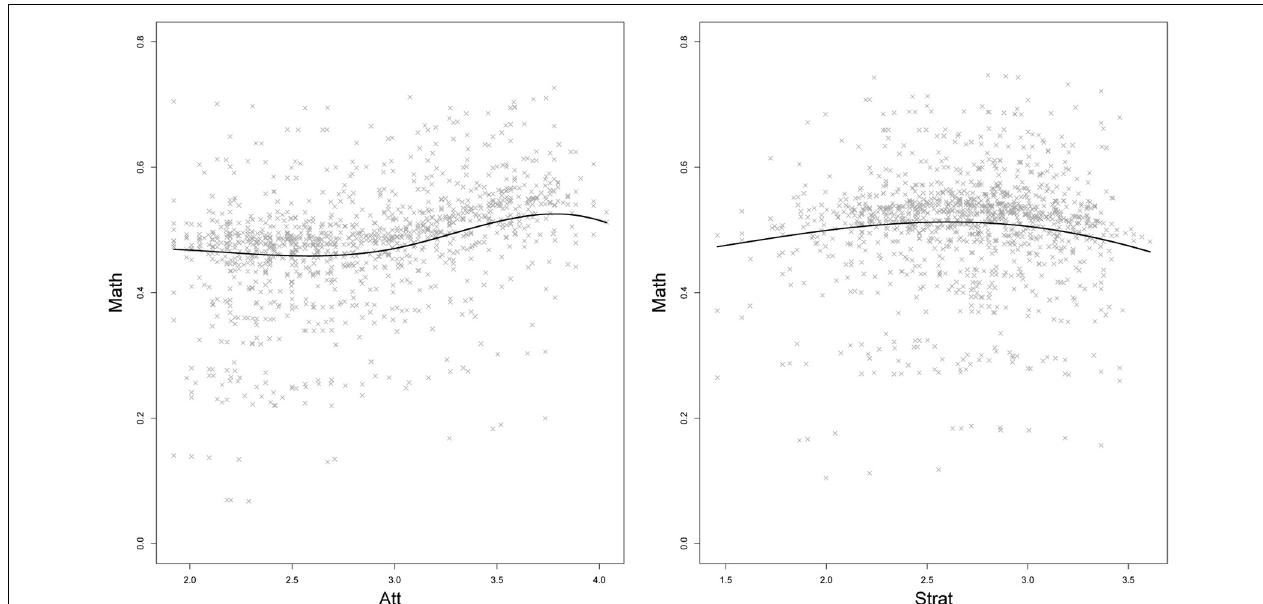
FIGURE 7 | Semiparametric Level-1 relationships between pupils’ math skills (Math) and their general attitude toward reading (Att; left), and Math and experienced teaching strategies (Strat; right).